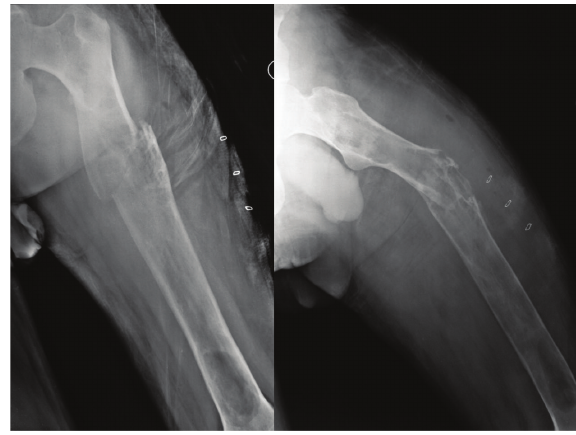
Figure 4: Pathological fracture of the left femur at the level of cortical destruction.